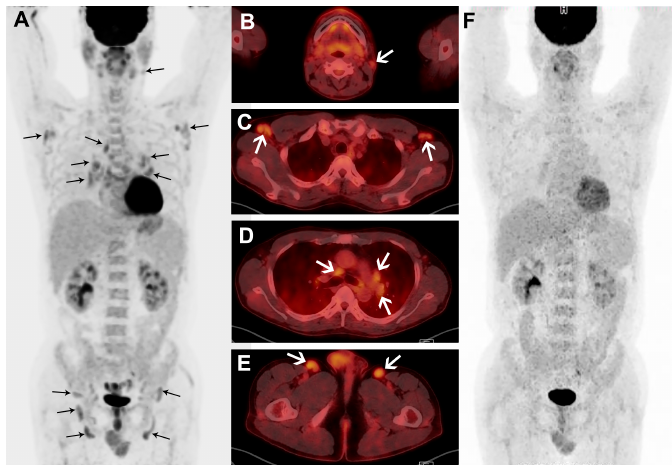
Figure 3. A male patient with plasma cell subtype of MCD confirmed by biopsy of right inguinal node. Maximum intensity projection ( A ) and transaxial fusion images ( B – E ) of treatment naïve FDG PET/CT show multiple, mildly enlarged LNs with mildly increased FDG uptake in bilateral cervical, axillary, mediastinal, bilateral hilar, perigastric, bilateral iliac, and inguinal areas (black and white arrows). The patient’s hemoglobin and albumin levels were low, while the hs-CRP level was high. In the FDG PET/CT performed to monitor the response to six cycles of chemotherapy, the nodal FDG uptakes are resolved in the maximum intensity projection image ( F ).